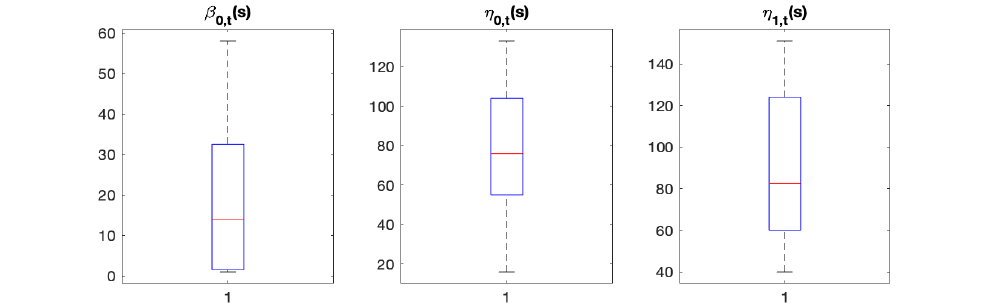
Figure A5. Boxplots of the numbers of distinct coefficients at years 2001–2020 for Model-1c.